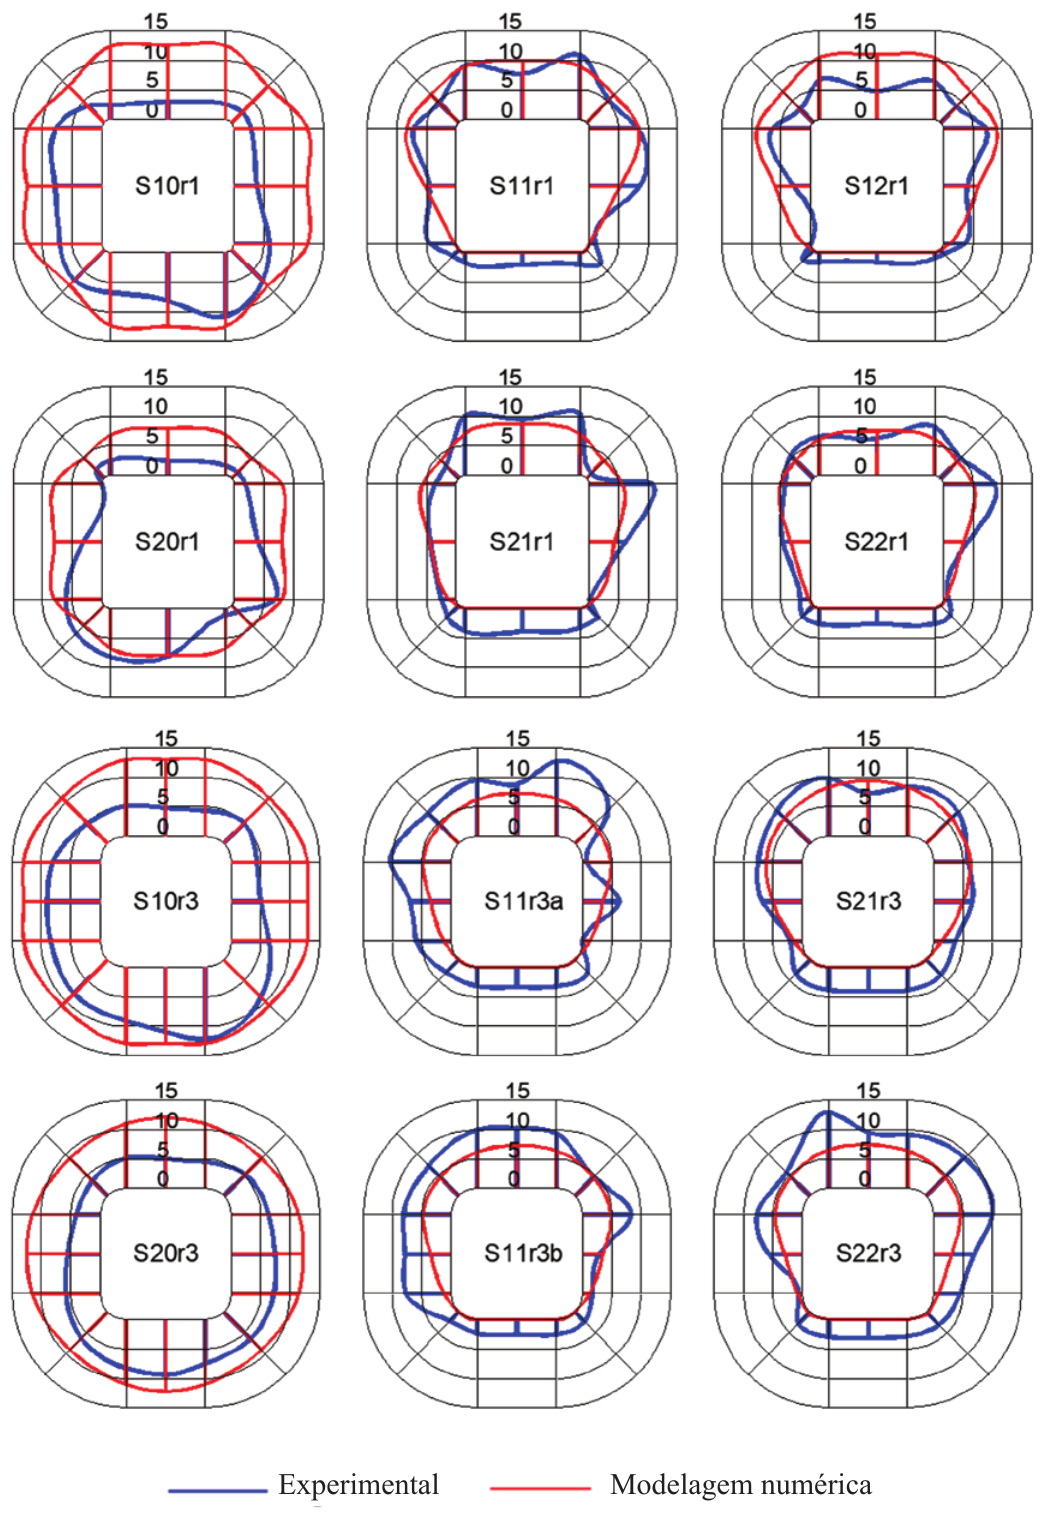
Experimental Modelagem Figure 8 Deformações no PRF ao longo do perímetro das seção intermediária dos pilares: comparação entre valores obtidos na modelagem numérica em relação aos obtidos nos ensaios experimentais por Carrazedo [17]. Séries 1 e 2 (unidades em ‰)